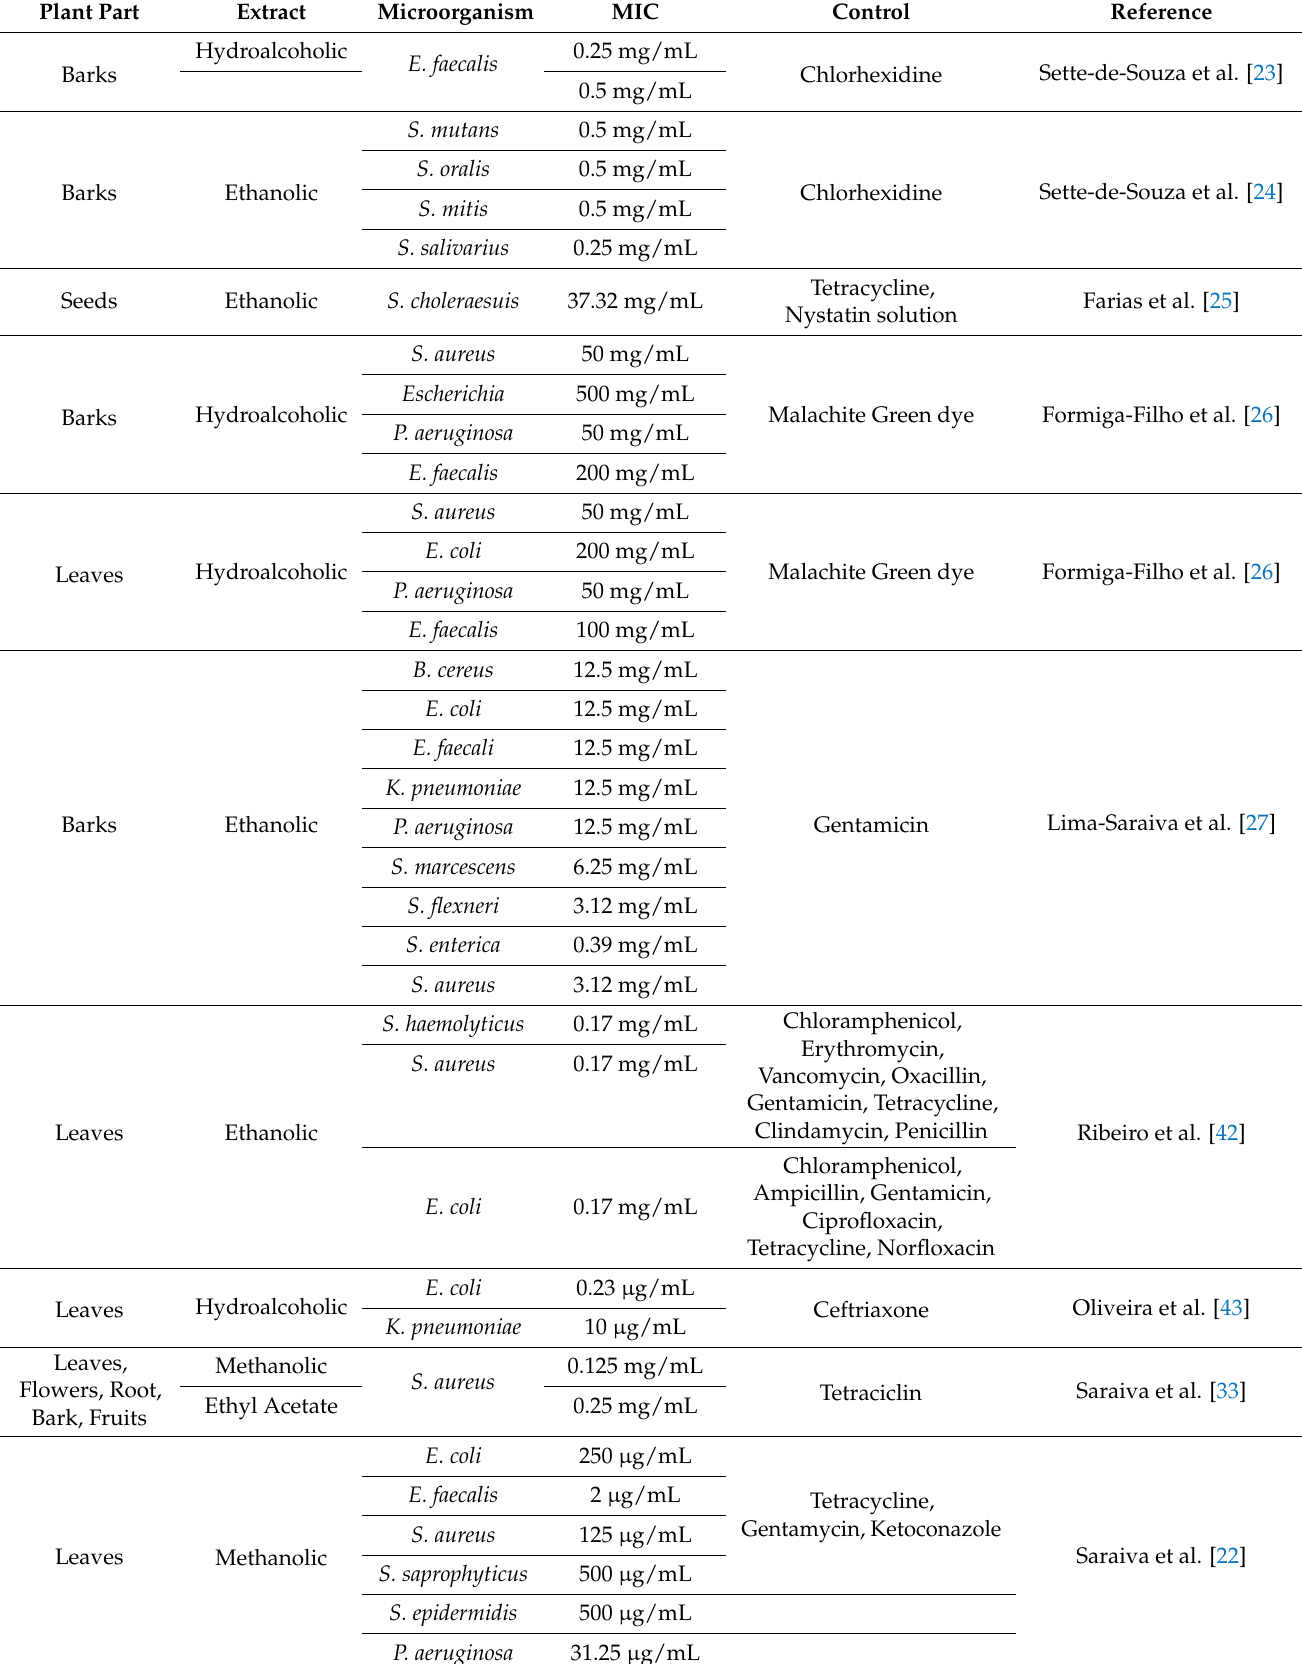
Table 4. Antimicrobial activity Schinopsis brasiliensis